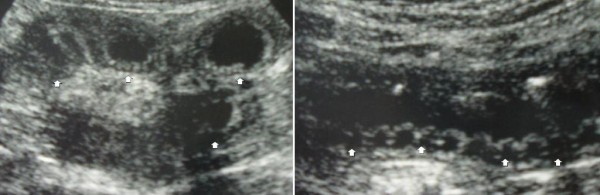
Ultrasonography of the abdomen. (A) Left image shows dilated bowel, diffuse bowel wall thickening (arrow). (B) Right image shows submucosal edema (arrow).